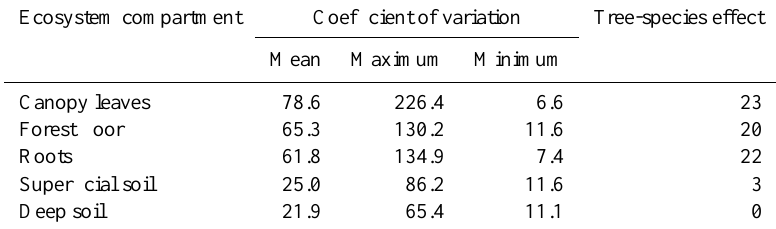
Table 1. Variability of the concentration of 23 chemical elements in five ecosystem compartments: mean, maximum and minimum values of CV. Tree-species effect indicated by the number of chemical elements showing significant variability due to tree-species identity, according to the ANOVA or Kruskal–Wallis